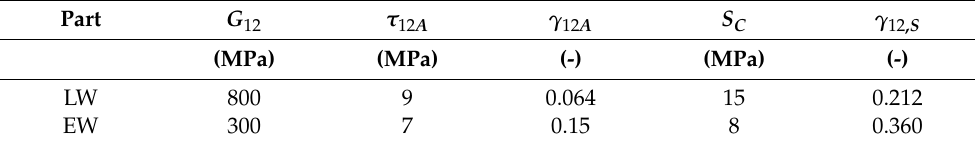
Table 3. Calibrated material parameter for in-plane shear behavior for EW and LW.